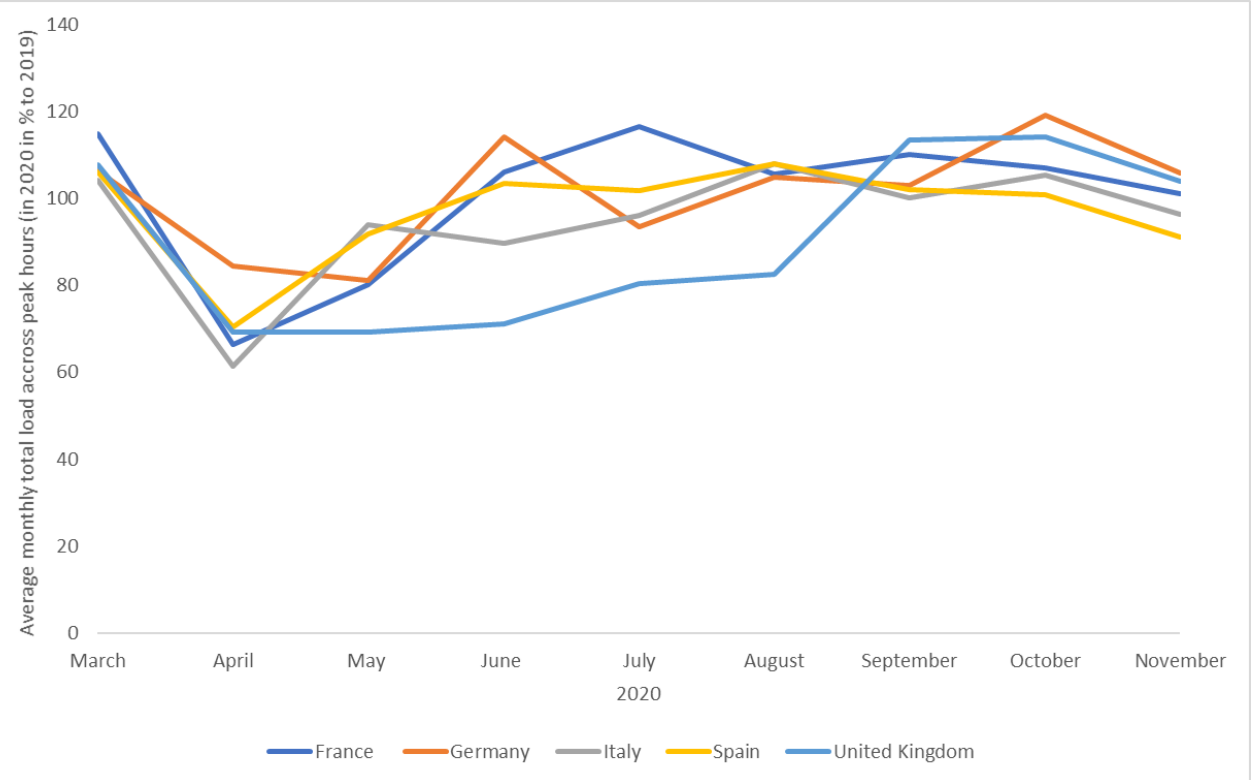
Figure 1. Average monthly electricity load in selected European Union (EU) countries for 2020 compared to 2019. Source: created by the authors based on [68,69].